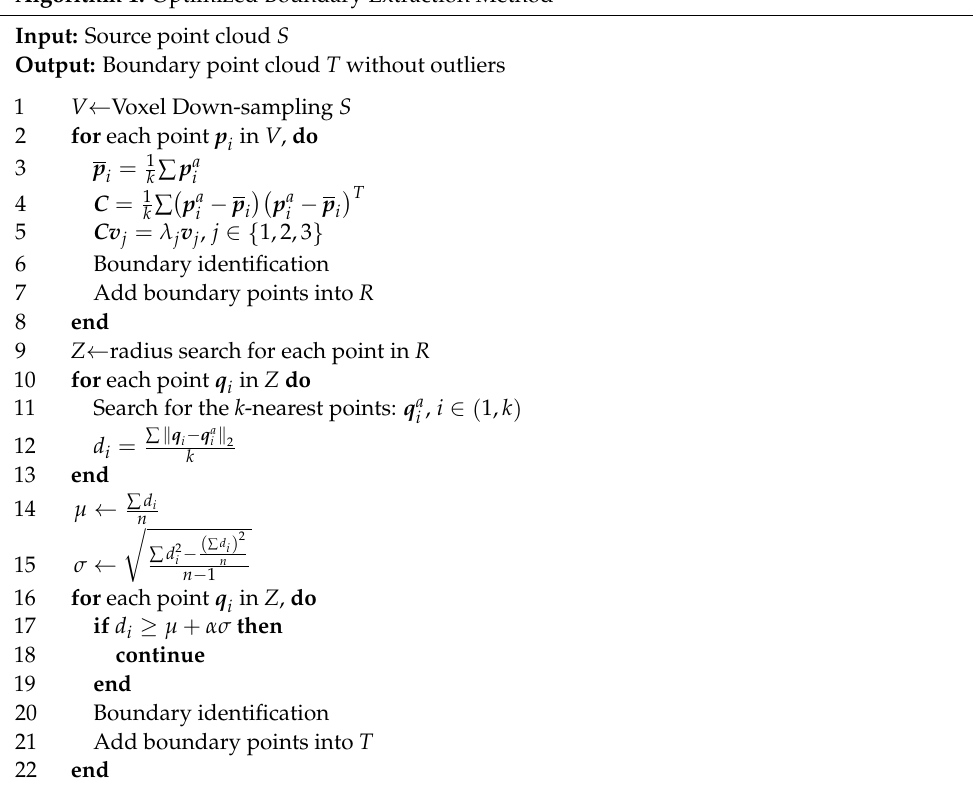
Algorithm 1. Optimized Boundary Extraction